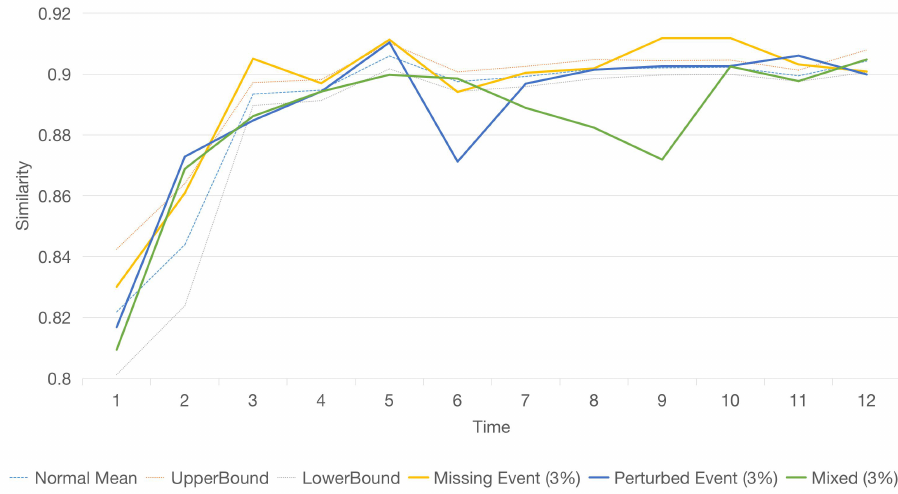
Figure 16. Detection of an anomaly with 3% occurrence probability. First detection of missing event is slow as it shows less deviation compared to other anomalies. However, it was successfully detected after 15